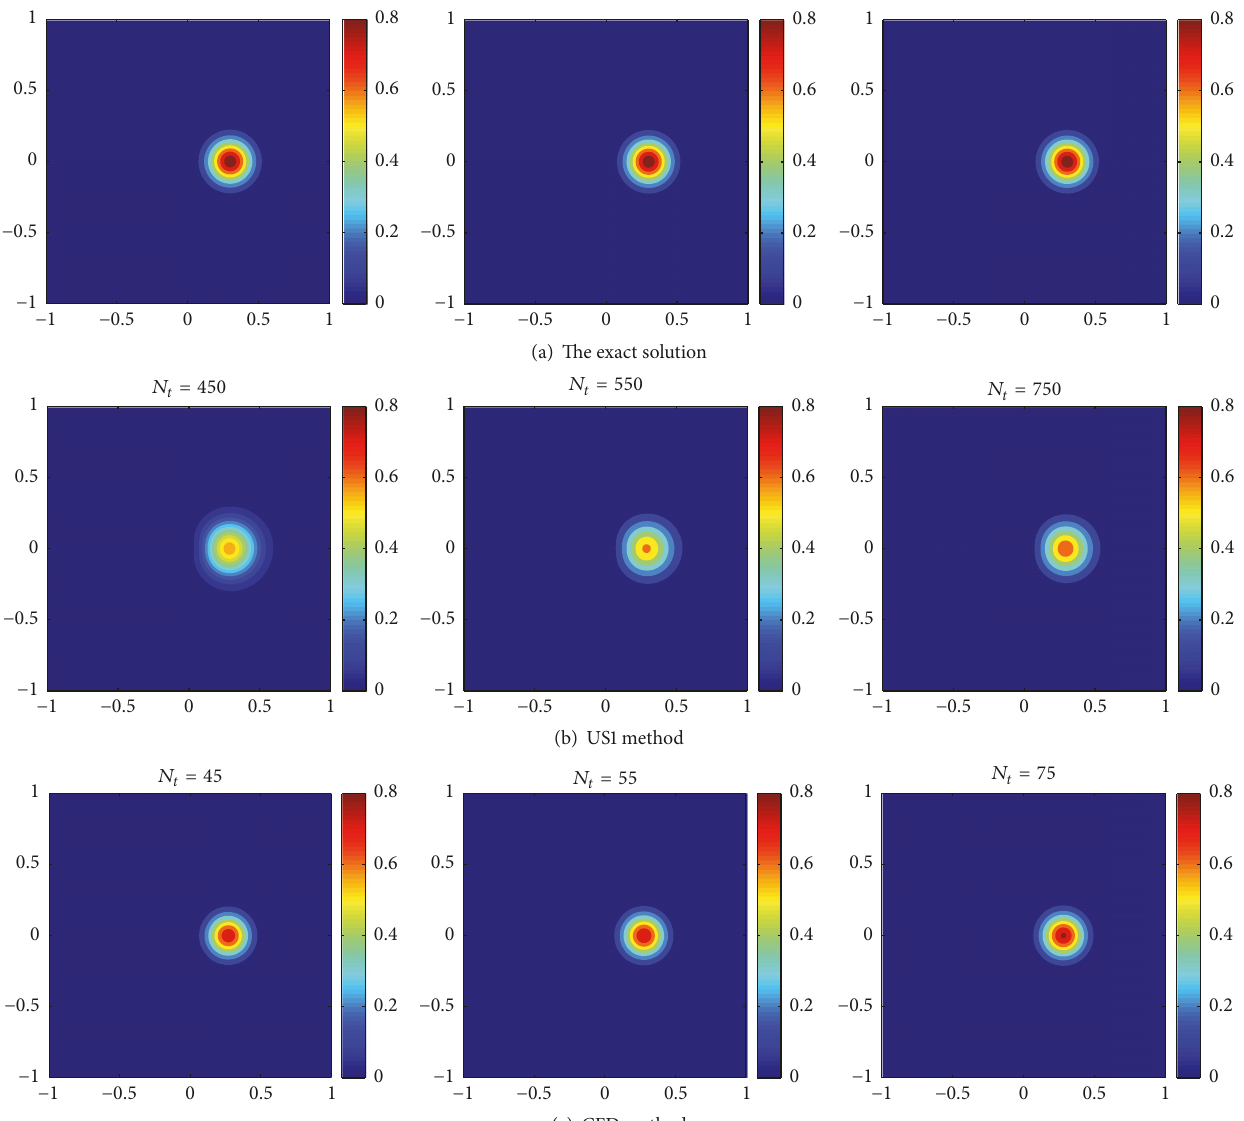
Figure 2: The results of (b) the US1 method and (c) the CFD method at 𝑇 = 𝜋/4 using different time steps and proportional space steps comparing with (a) the exact